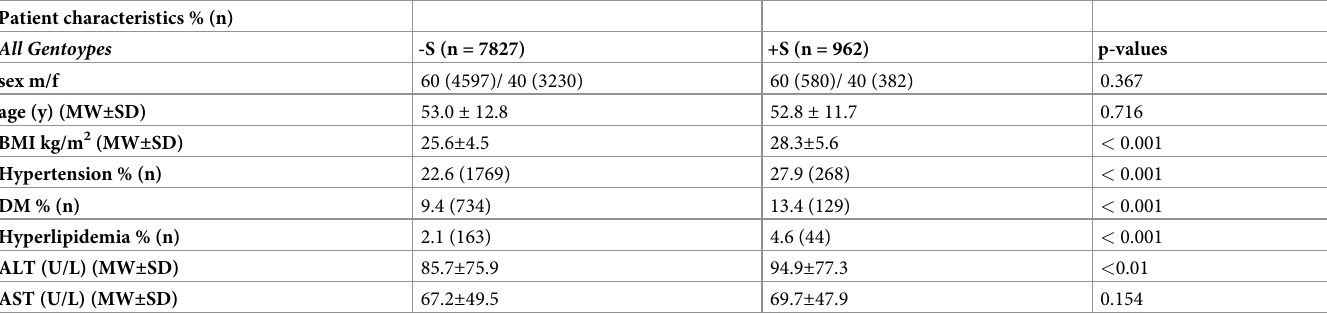
Table 1. Baseline characteristics of HCV patients including all